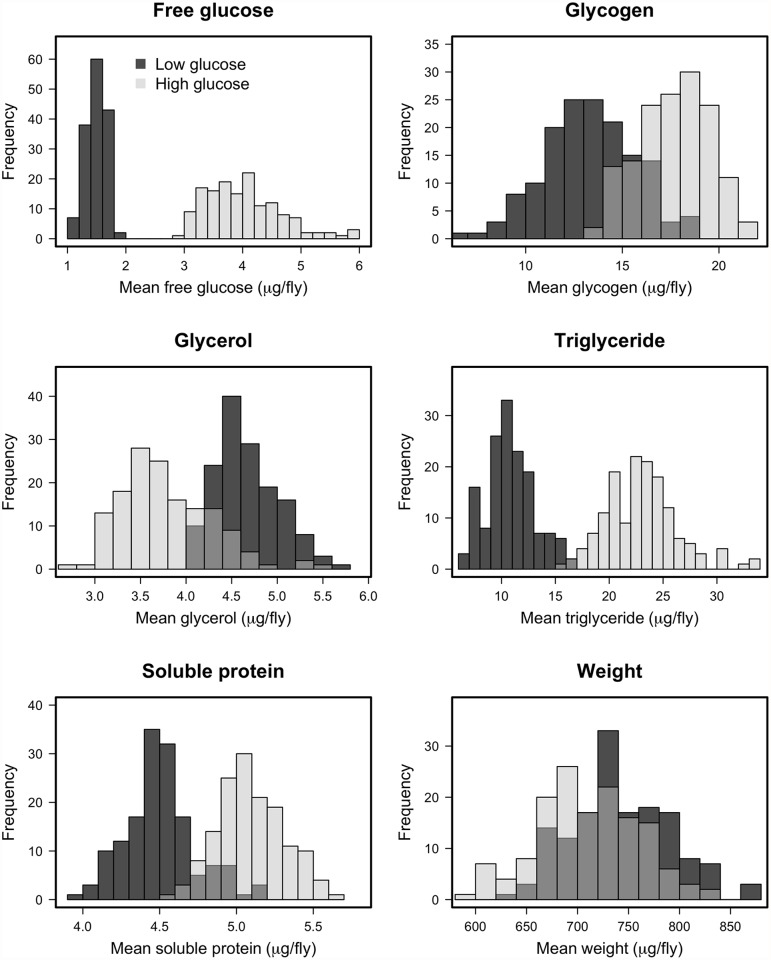
Histograms of estimated line means for nutritional indices for DGRP lines reared on high glucose and low glucose diets.The differences in distributions on the high glucose and low glucose diets were highly significant (p < 10-4) in all cases, supporting the assertion that diet significantly alters the metabolic state of the fly.